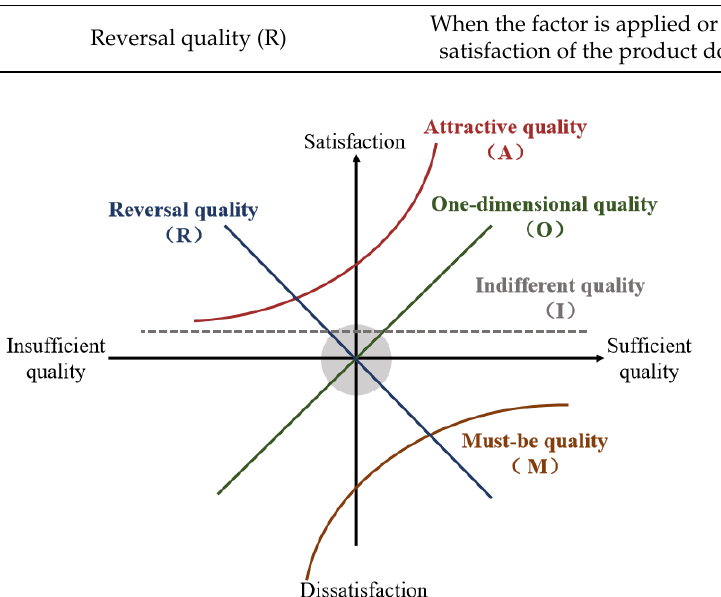
Figure 2. Relationship between quality performance and user satisfaction of Kano types [31,32].